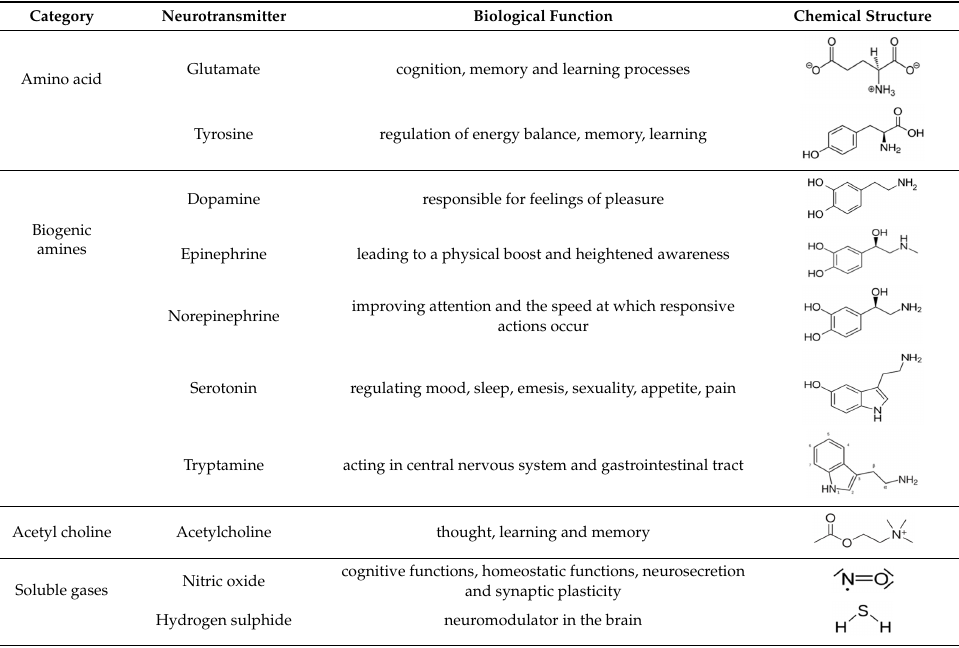
Table 1. Table 1. Classification of neurotransmitters, biological function and chemical structures [3]. Table 1. Classification of neurotransmitters, biological function and chemical structures [3]. Table 1. Classification of neurotransmitters, biological function and chemical structures [3]. Table 1. Classification of neurotransmitters, biological function and chemical structures [3]. Table 1. Classification of neurotransmitters, biological function and chemical structures [3]. Table 1. Classification of neurotransmitters, biological function and chemical structures [3]. Table 1. Classification of neurotransmitters, biological function and chemical structures [3]. Table 1. Classification of neurotransmitters, biological function and chemical structures [3]. Table 1. Classification of neurotransmitters, biological function and chemical structures [3]. Table 1. Classification of neurotransmitters, biological function and chemical structures [3]. Table 1. Classification of neurotransmitters, biological function and chemical structures